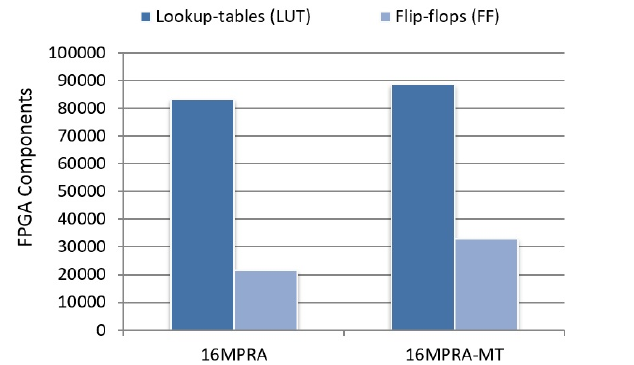
Fig. 7. FPGA resource usage corresponding to the nMPRA and nMPRA-MT processor configurations, with 16 threads